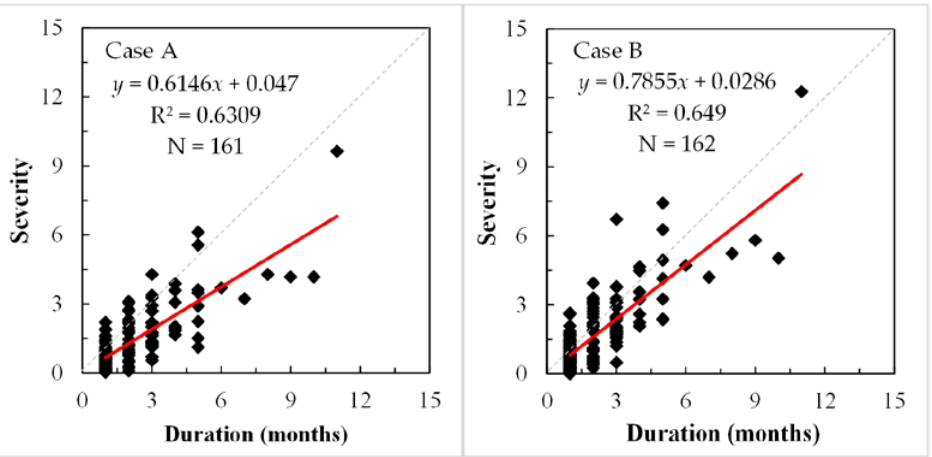
Figure 4. Scatter plot with fitted regression line of drought duration and severity of drought events obtained from two different processing schemes for the Poyang Lake Basin in 1957–2014.